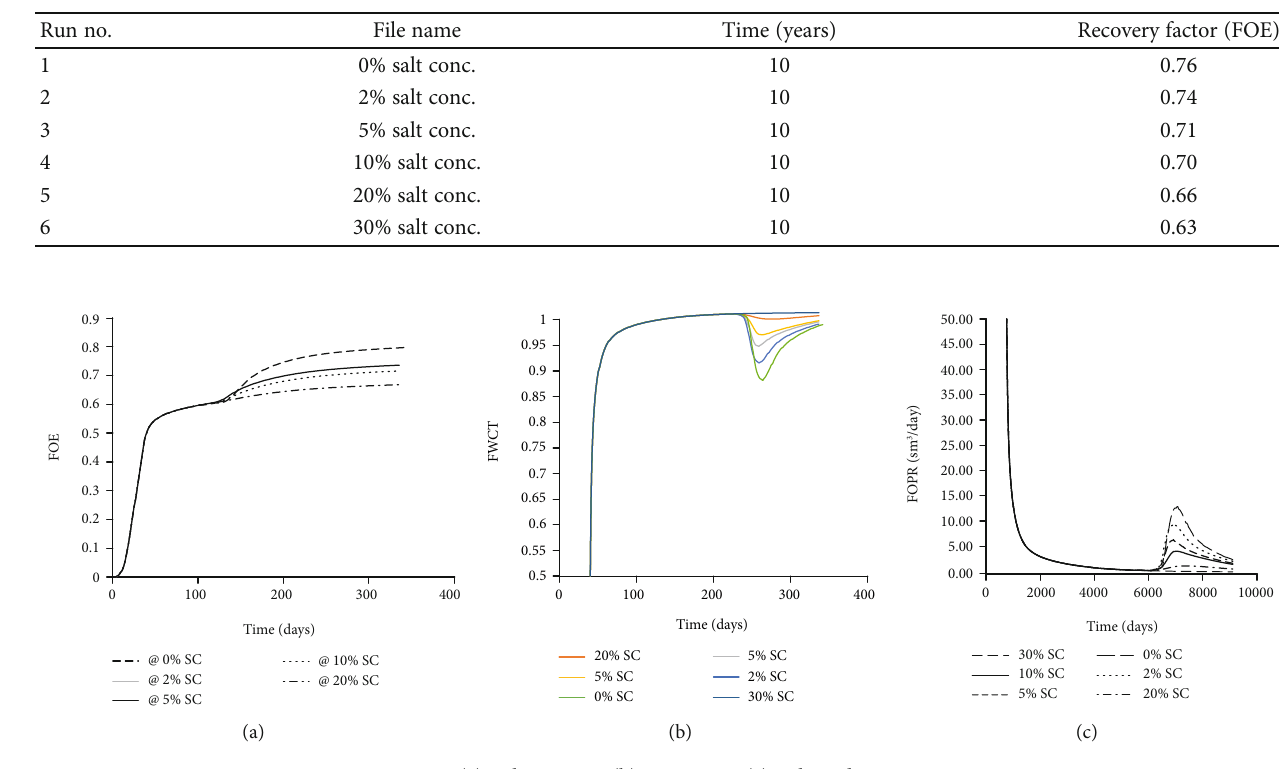
Figure 1: FlowViz description of reservoir. Table 5: Oil recovery factor for Case 1.